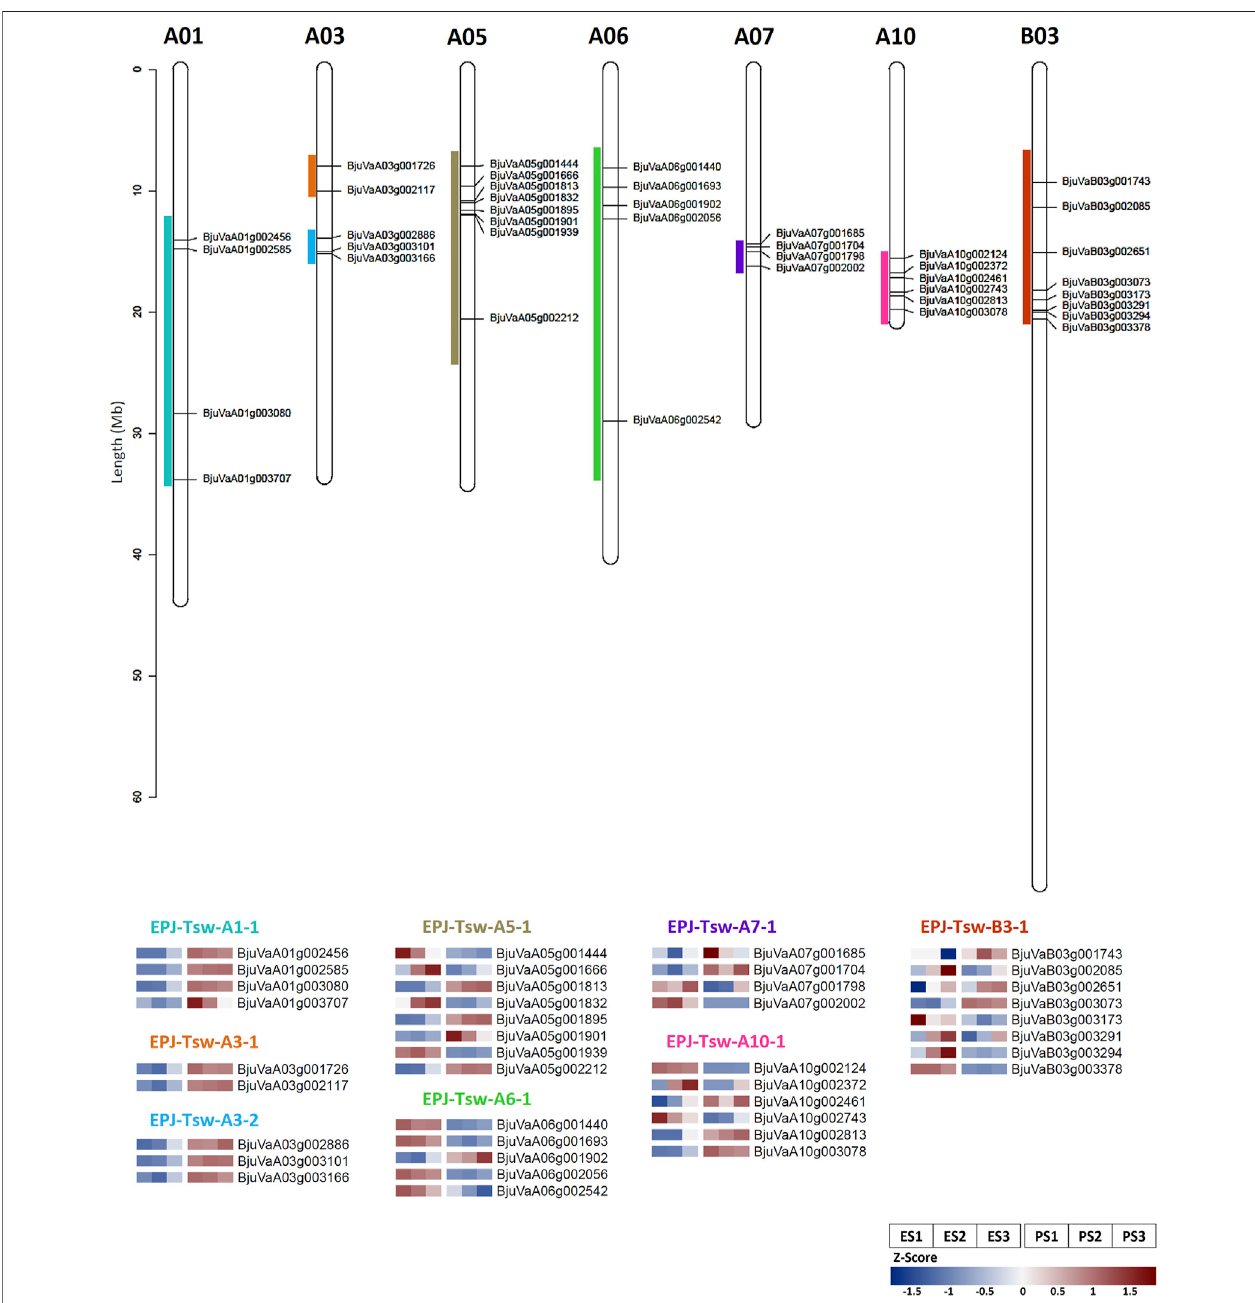
FIGURE5| CandidategenesforregulationofseedsizeinEH-2andPJcolocalizingtheEPJTswQTL.Genomiclocations(inEPJTswQTL)andexpressionpro fi les (Z-score) of selected candidate genes at stages S1 – S3 in EH-2 and PJ. E, EH-2; P, PJ; S1 – S3, seed development stages; Tsw, thousand seed weight.